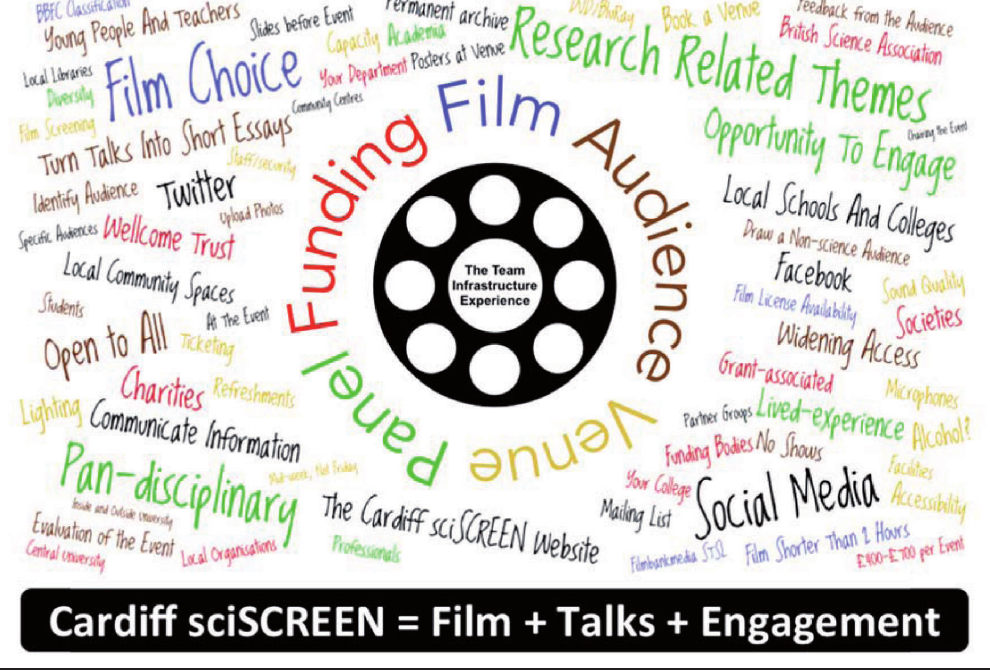
Figure 1: The Cardiff sciSCREEN Experience We have constructed a word cloud to represent the fundamental ingredients involved in organizing a Cardiff sciSCREEN event. Five essential components are key to organizing a Cardiff sciSCREEN, and are coloured accordingly: (1) choice of film – blue, (2) funding – red, (3) the venue – gold, (4) the audience – brown and (5) the panel of experts – green. These are encircled by the many factors that need to be considered when organizing an event and are coloured to fit the correct category. Factors coloured in black relate to communication